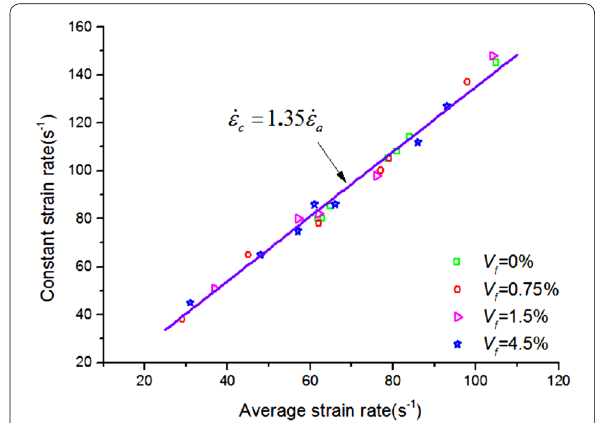
Fig. 5 Relationship between actual strain rate and average strain rates.